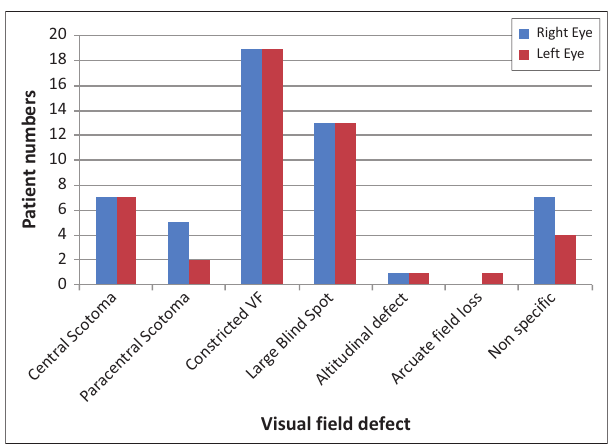
FIGURE 1: Frequencies of visual field